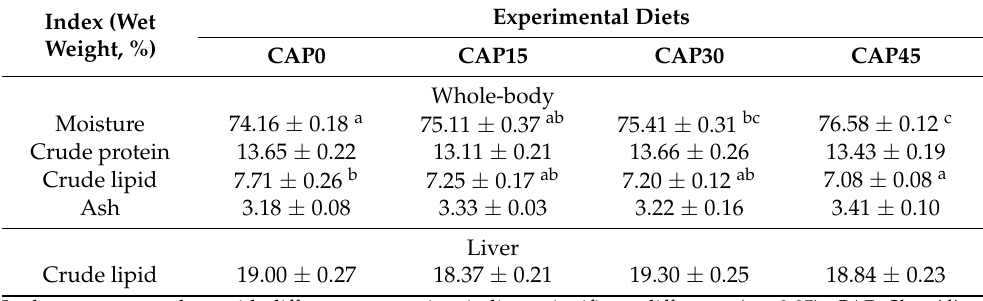
Table 4. Body compositions of large yellow croakers fed diets with different levels of CAP for 56 days.